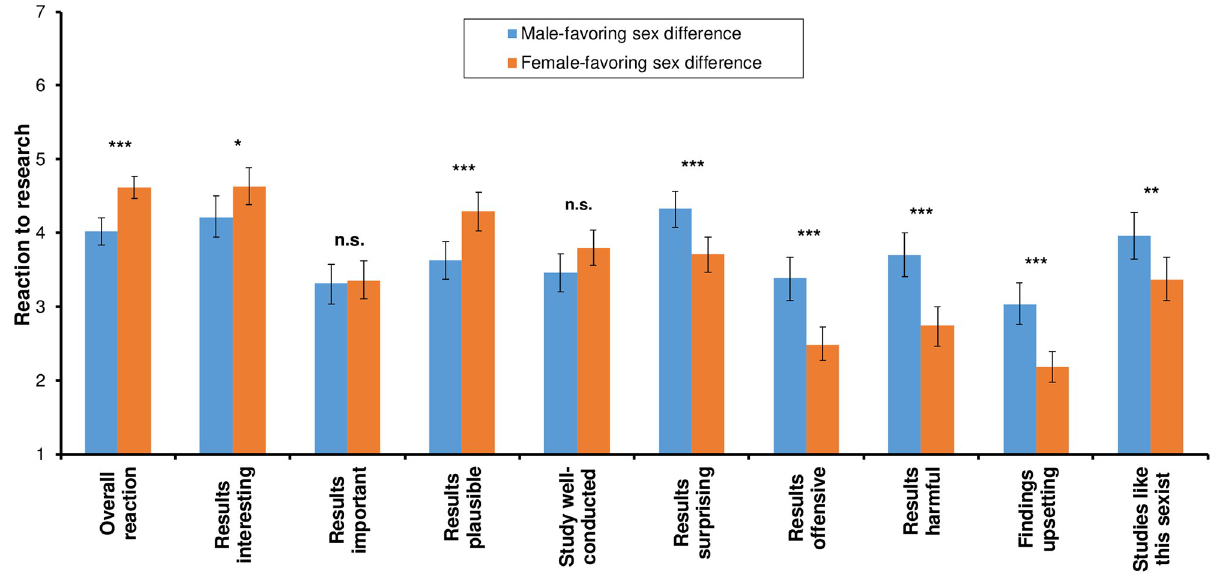
Fig 1. Participants’ reactions to fictitious research describing a male- vs. a female-favoring sex difference. Higher scores on the “Overall reaction” variable indicate a more positive reaction to the research; higher scores on the individual items indicate stronger agreement that the descriptor applies to the research. � p < .05; �� p < .01; ��� p < .001; n.s.: not significant. Error bars = 95% CIs.